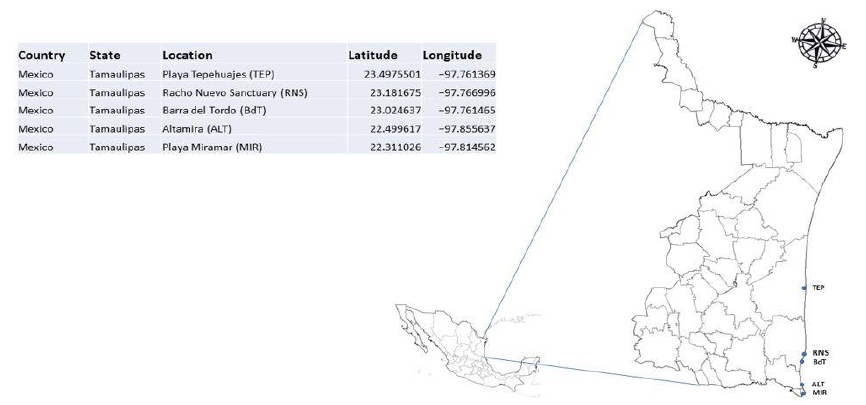
Figure 1. Location of the main Kemp’s ridley nesting beaches in Tamaulipas, Mexico. The figure shows the name and abbreviations of the nesting beaches and their respective Latitude and Longi- tude.